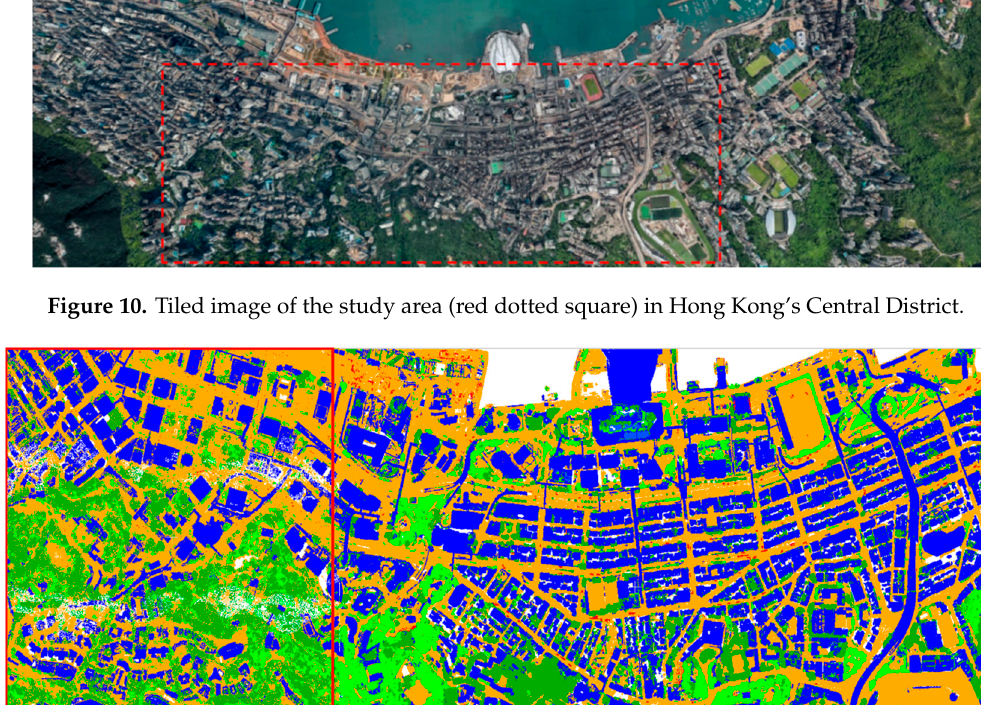
Figure 12. The semantic labeling results of the Hong Kong dataset using the proposed method in 3D.